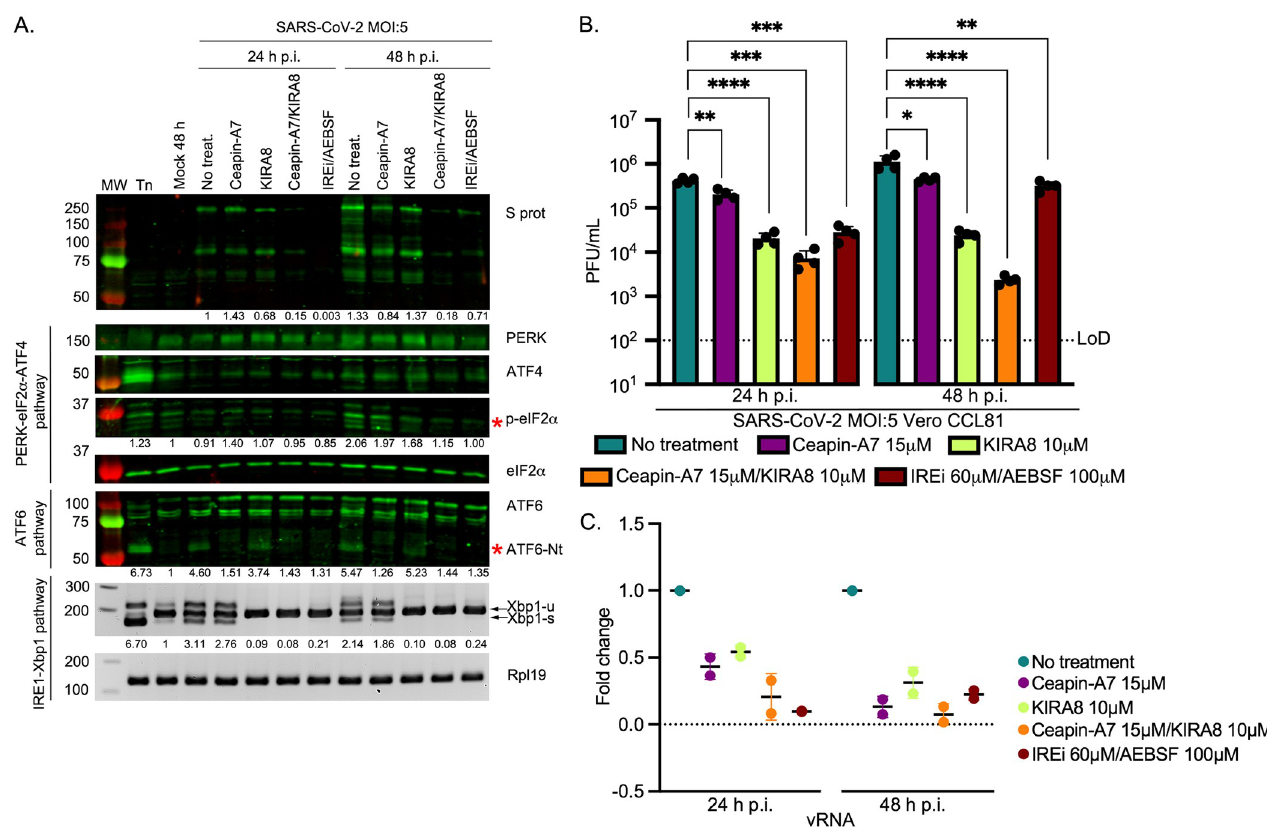
Fig 6. Effect of specific inhibition of IRE1 α and ATF6 pathways on SARS-CoV-2 replication. Vero CCL81 cells were incubated in the presence of tunicamycin (2 μ g/ml) or infected with SARS-CoV-2 (MOI 5) and treated with 15 μ M Ceapin-A7 and 10 μ M KIRA8 as individual treatments or in combination. The inhibitors were added to the cells immediately after the virus adsorption period and maintained in the medium for 24 or 48 h. (A) Western blot analysis (upper) of SARS-CoV-2 S, PERK, ATF4, p-eIF2 α and ATF6. The specific p-eIF2 α and ATF6-Nt bands are indicated by red asterisks. Protein band quantifications, normalised by eIF2 α as a loading control and given relative to the mock, are provided below the respective immunoblots. RT-PCR analysis of XBP1-u and XBP1-s mRNAs (lower), performed as described in Fig 2D. Immunoblots and agarose gels are representative of three biological replicates. (B) Plaque assays were performed with serial dilutions of the supernatant containing released virions at 24 and 48 h p.i. Values show the mean averages of the titration of four biological replicates. Error bars represent standard errors. All p- values are from comparisons with the respective untreated control, with � p < 0.05, �� p < 0.01, ��� p < 0.001 and ���� p < 0.0001. (C) RT-qPCR of vRNA from two biological replicates of Vero CCL81 cells infected and treated as described above. Data are normalised as described in Fig